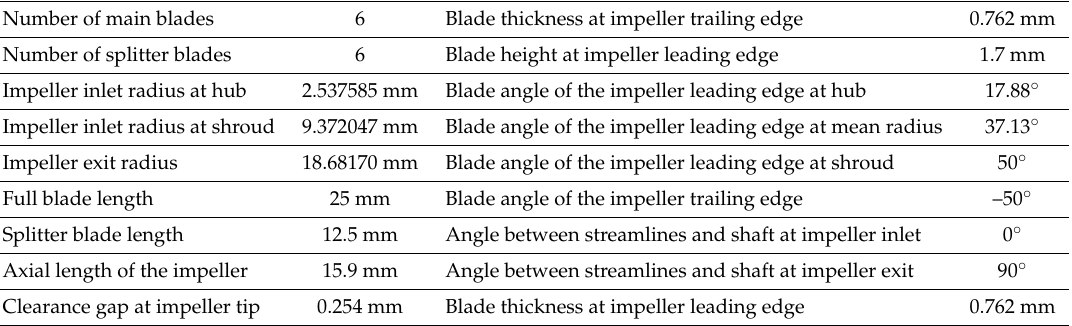
Table 1. Geometry details of the impeller.